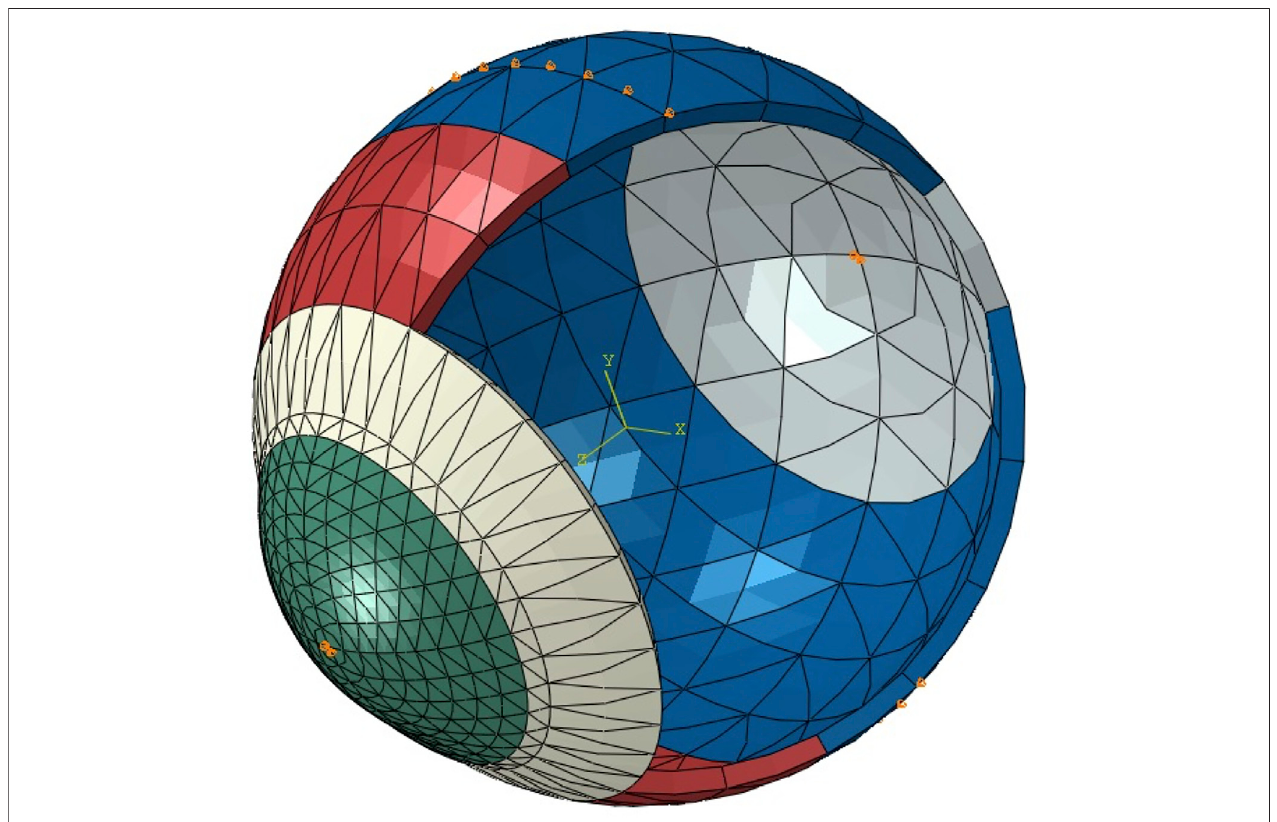
FIGURE 2 | A typical whole-eye fi nite element model showing the boundary conditions applied at the equator and corneal apex (orange pins).